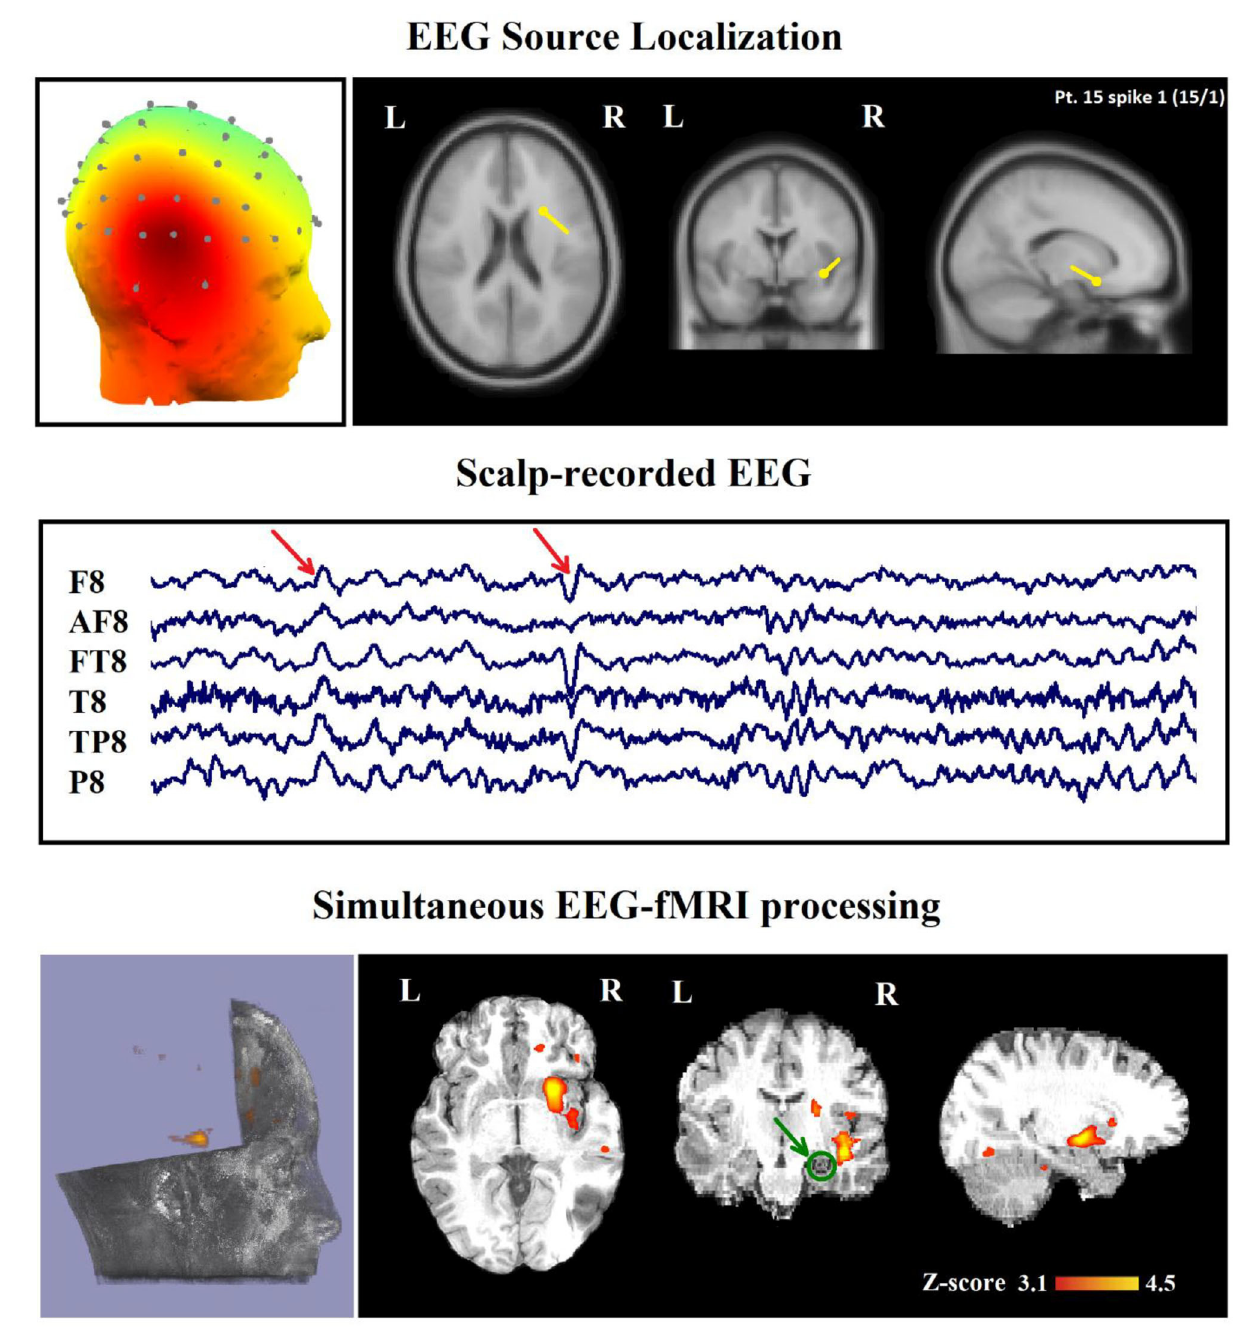
FIGURE 5 | (Patient 15, spike 1) Marked events are F8, FT8 spikes, and the TCCC-related BOLD response shows a neocortical activation in the right head and the superior temporal gyrus. This response is considered concordant with the spike field but not contributory. Based on the mesial temporal sclerosis (MTS), the patient has independent validation information, but the response is invalidated. The green circle shows the MTS area. Top, the component identified on scalp EEG located in the right temporal lobe (left) and the dipole localization of the identified generator in deep brain structures (right) based on analysis of EEG inside the scanner. Middle, scalp recorded EEG. Bottom, Localization of the generator applying simultaneous analysis of EEG-fMRI. The active area is marked with a yellow-red color.